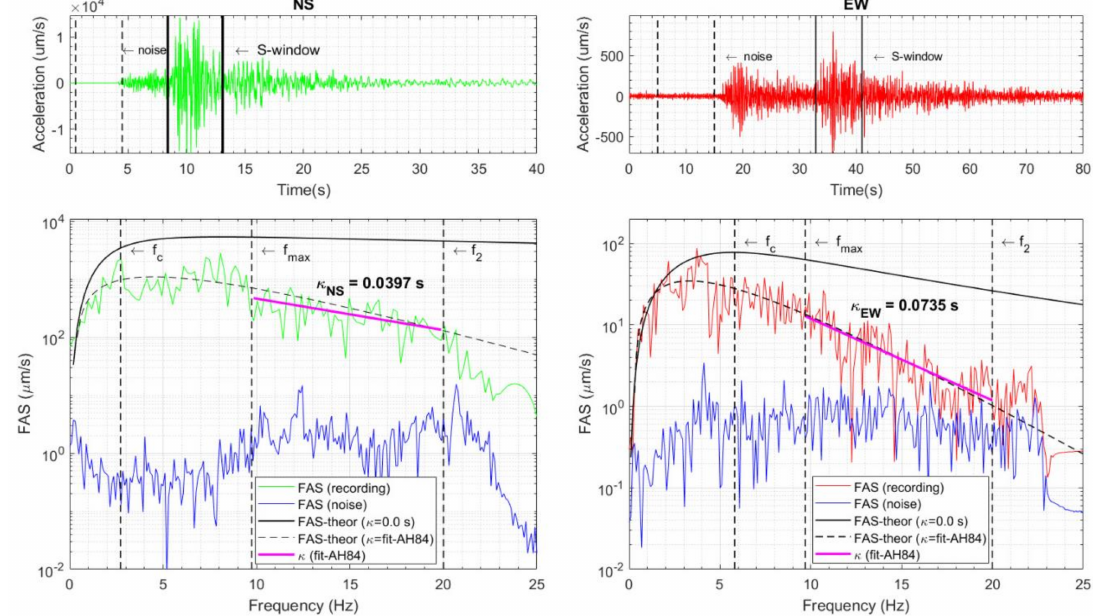
Figure 4. Example of κ calculation. ( left ) Station PTJ. M L = 4.2, R e = 34 km, NS component. ( right ) Station ZAG: M L = 3.5, R e = 128.5 km, EW